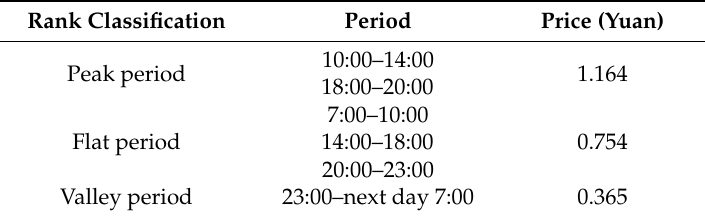
Table 4. Tariff according to TOU [27].